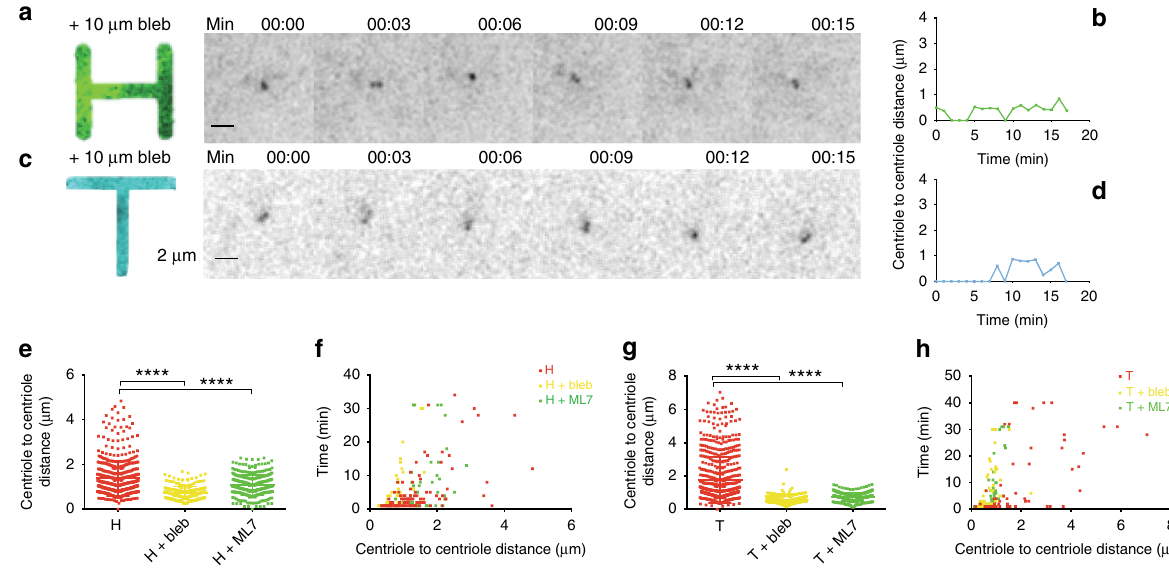
Fig. 4 Actin contractility inhibition impairs centriole separation. Representative videos of C1-GFP HeLa cells plated on H ( a ) and T ( c ), treated with 10 μ M blebbistatin (bleb). Time is in minutes (min). Images correspond to Supplementary Movies 5 – 6. b , d Centriole-to-centriole distance plotted over time for the respective videos. Centriole-to-centriole distance for all cells and time points ( e , g ) and open time versus centriole-to-centriole distance ( f , h ) for control, blebbistatin (bleb) or ML7 treated (both myosin ATP activity inhibitors) cells on H and T patterns (H control n = 46 cells; H + bleb n = 16 cells; H + ML7 n = 18 cells; T control n = 37 cells; T + bleb n = 22 cells; T + ML7 n = 21 cells). Time is in minutes (min). Error bars represent s.e.m. p -value was obtained with one-way Anova test. **** p < 0.0001. Scale bar: 2 μ